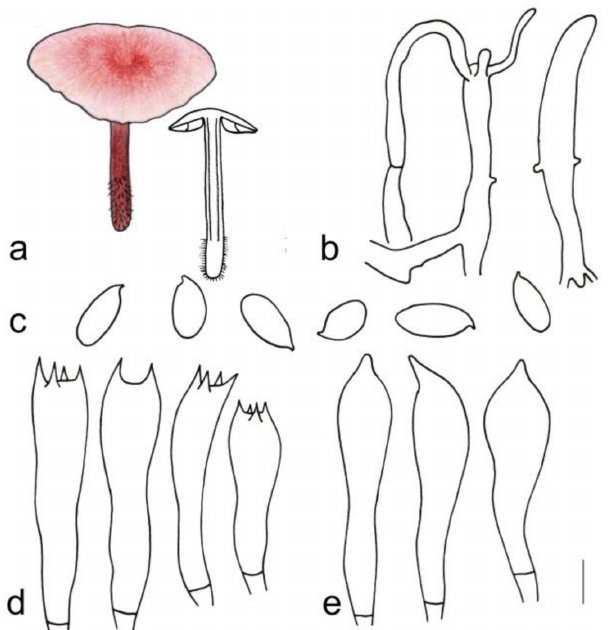
Figure 8. Morphological characteristics of Gymnopus changbaiensis (HMJAU 60300, holotype): ( a ) basidiomata, ( b ) pileipellis, ( c ) basidiospores, ( d ) basidia, and ( e ) cheilocystidia. Scale bars: 1 cm ( a ), 25 µ m ( b ), and 5 µ m ( c – e ). Gymnopus tomentosus J.J. Hu, B. Zhang and Y. Li sp.